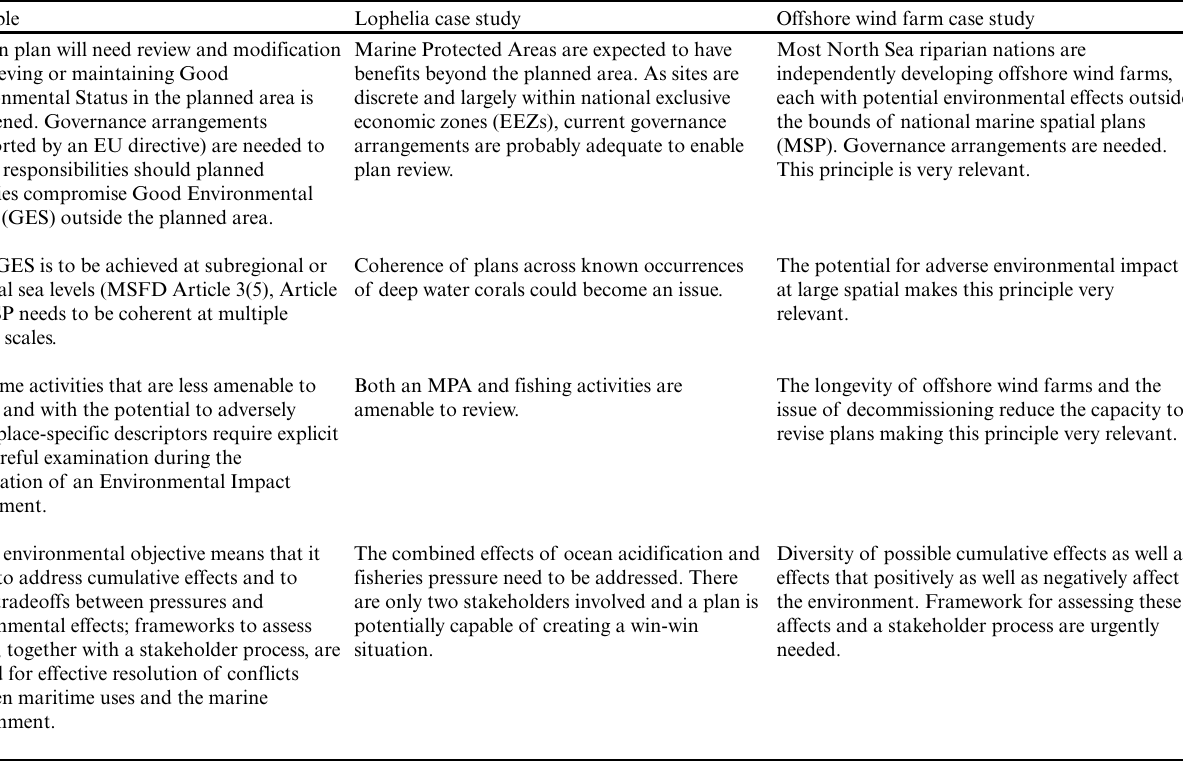
Table 5 . Relevance of four principles to the two case